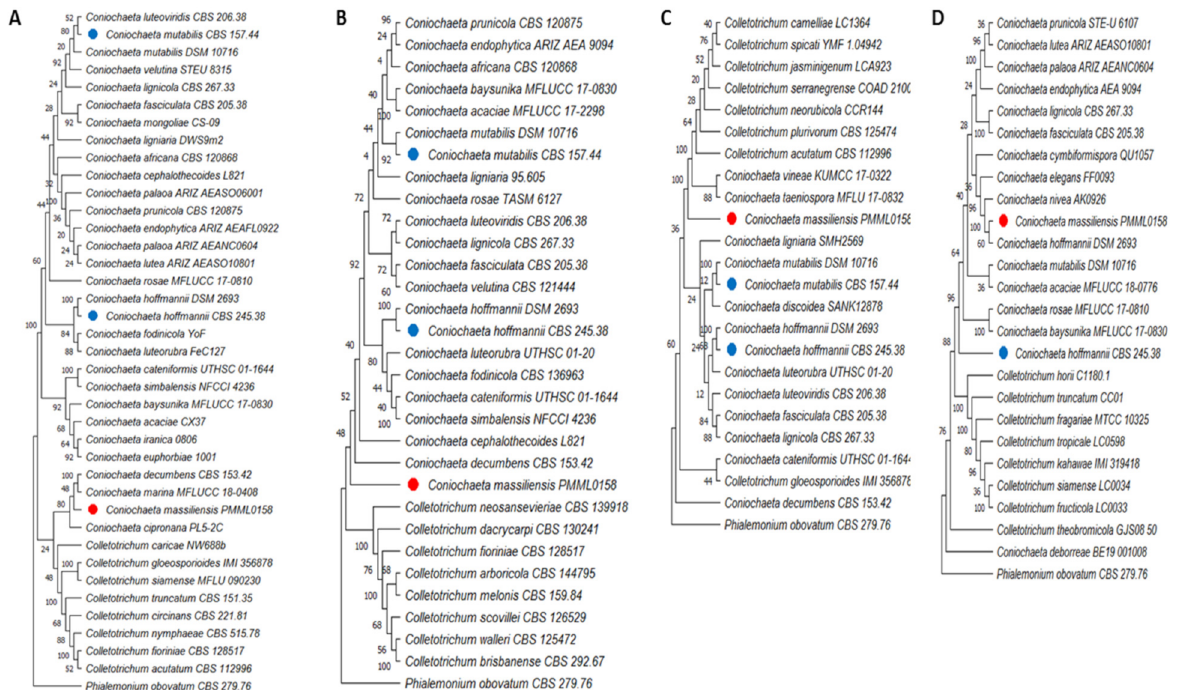
Figure 7. Four single-locus phylogenetic trees using the ITS ( A ), D1/D2 ( B ), B-tub2 ( C ), and TEF-1 α ( D ) genomic regions. The species included in each tree differ because the sequences for each locus were not available for all strains. The red dots indicate the new species Coniochaeta massiliensis PMML0158 and blue dots indicate type strains. Phialemonium obovatum CBS 279.76 was used as the outgroup. The maximum-parsimony tree was generated using the MEGA 11 software, with 1000-replication bootstrap